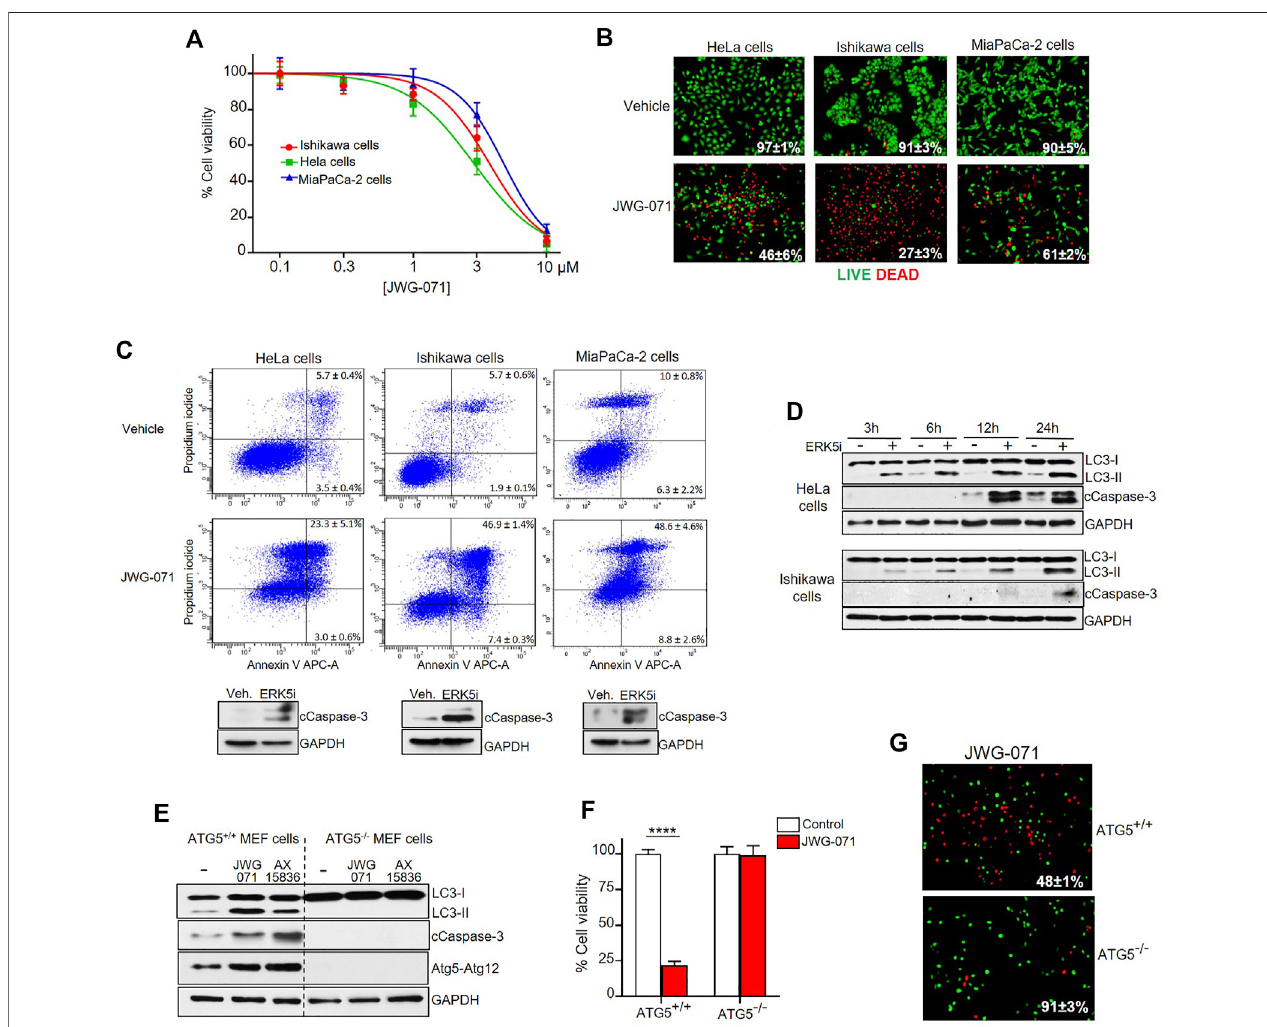
FIGURE 3 | ERK5 inhibition induces autophagy-mediated apoptotic cancer cell death. (A) ERK5i induces cytotoxicity. MTT cytotoxicity assay in a panel of human Cancer cells. JWG-071 was incubated for 48 h at the indicated concentrations. Values represent mean ± SD of three independent experiments, each performed in tetraplicates. (B) ERK5iinducescelldeath.Cellsweretreatedwith10 μ MJWG-071for36 h,stainedwithLIVE/DEADreagent,andalive(green)anddead(red)cellswere visualized by fl uorescence microscopy. Figure shows representative fi elds, and percetage of alive cells is given. (C) ERK5i induces apoptotic cancer cell death. Percentage of apoptotic cells was determined by fl ow cytometry (Annexin V/Propidium iodide staining) at 48 h following treatment with 5 μ M JWG-071. Representative fl ow cytometry plots of cells are shown. Similar results were obtained in three independent experiments, each performed in duplicates. Immunoblot panels show